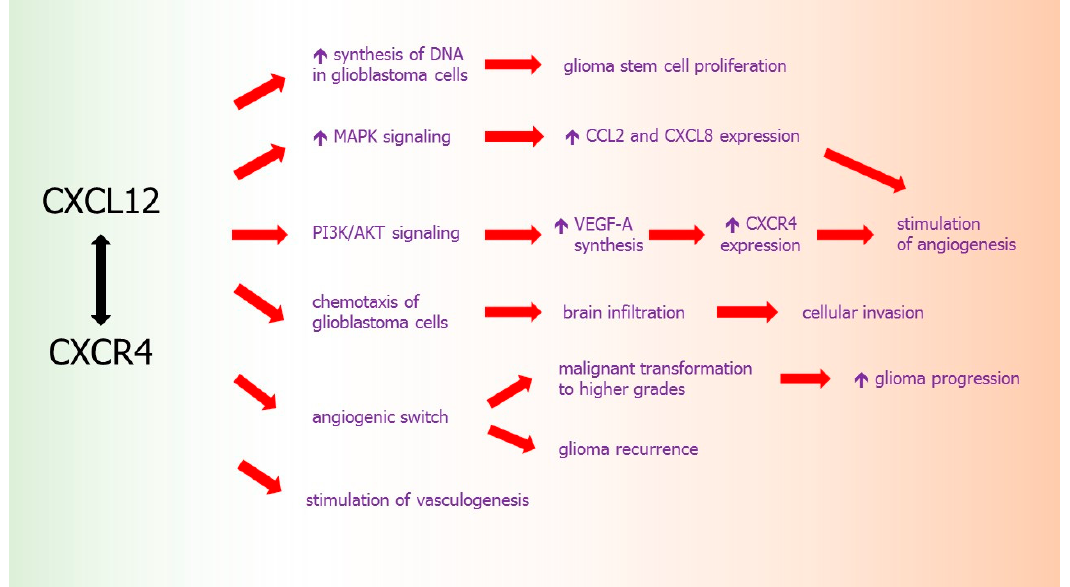
Figure 3. CXCL12-CXCR4 axis in glioma development. Red arrows: effects of chemokine activity, black arrow: chemokine-receptor axis.